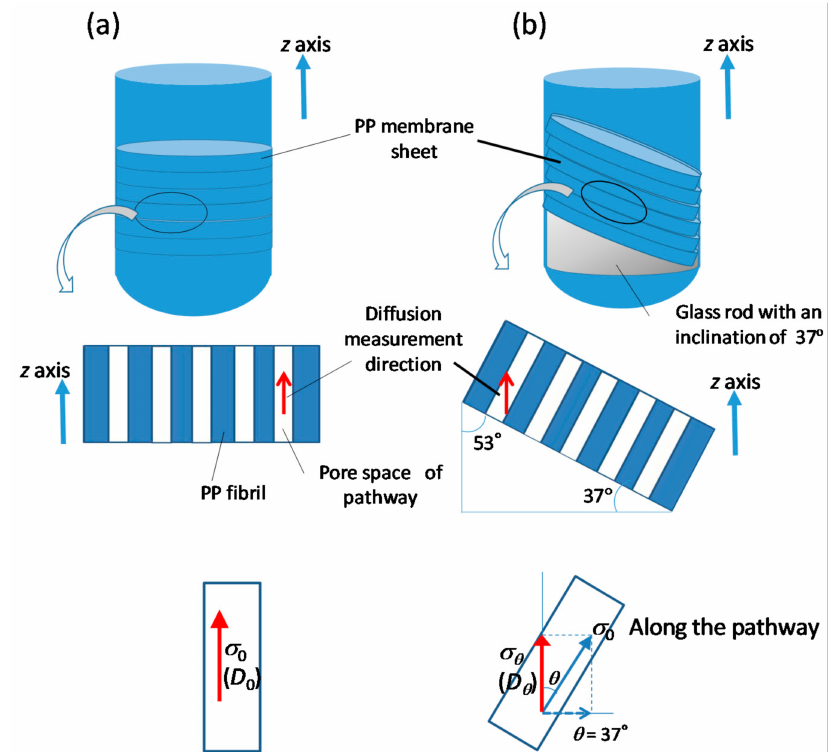
Figure 8. Schematic illustrations showing the direction of diffusion with respect to the straight pathway of the aligned-pore membranes: ( a ) vertically stacked polypropylene (PP) membrane sheets; ( b ) PP membranes inclined at an angle of 53 ◦ from the longitudinal axis (z-axis) of the sample tube. The z-axis corresponds to the diffusion measurement direction. The middle illustrations represent the internal structure of the aligned-pore membrane with straight pathways: (blue) PP stem fibril; (white) pore space for ion movement. The lower illustration represents the diffusion components that are detected (red arrows) and the respective conductivity components. In the case of (b), σ θ = σ 0 cos 2 θ is satisfied when D θ = D 0 cos 2 θ . If the effect of ionic collision with the wall on the diffusivity in the inclined direction is larger than that on D 0 , D θ < D 0 cos 2 θ and the subsequent relationship σ θ < σ 0 cos 2 θ are satisfied. Reprinted with permission from [37]. Copyright 2019 ACS